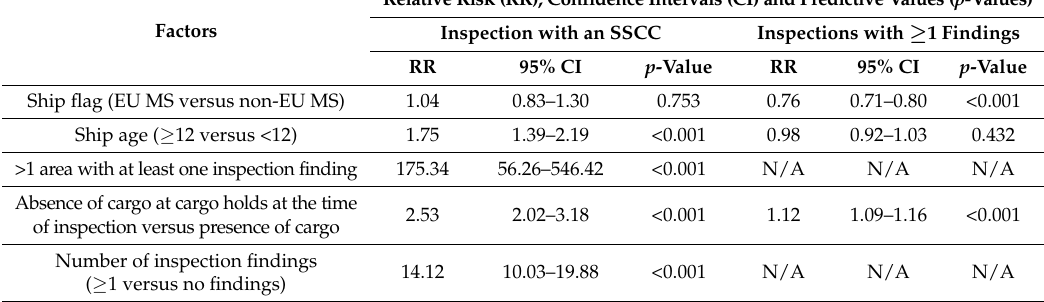
Table 4. Univariate analysis of factors in relation to Ship Sanitation Control Certificates (SSCCs) and to the number of inspection